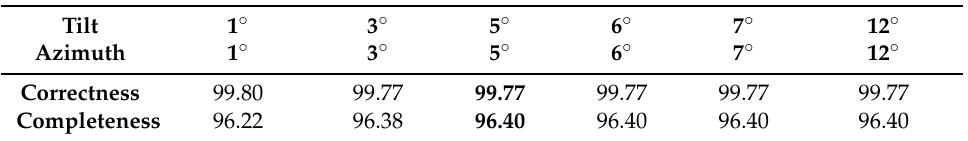
Table 6. Completeness and correctness percentage for different values of the maximum angular difference in tilt and azimuth between